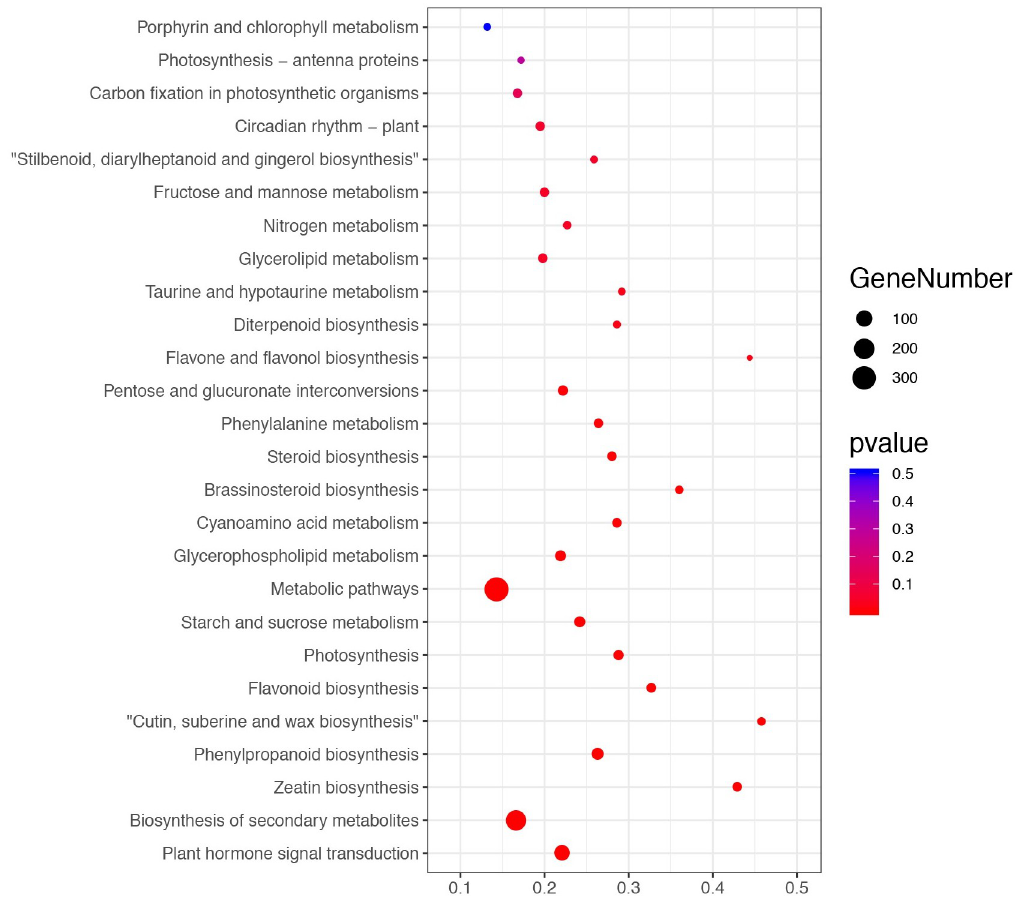
Fig 5. Bubble diagram demonstrating the enrichment of KEGG pathway terms in each